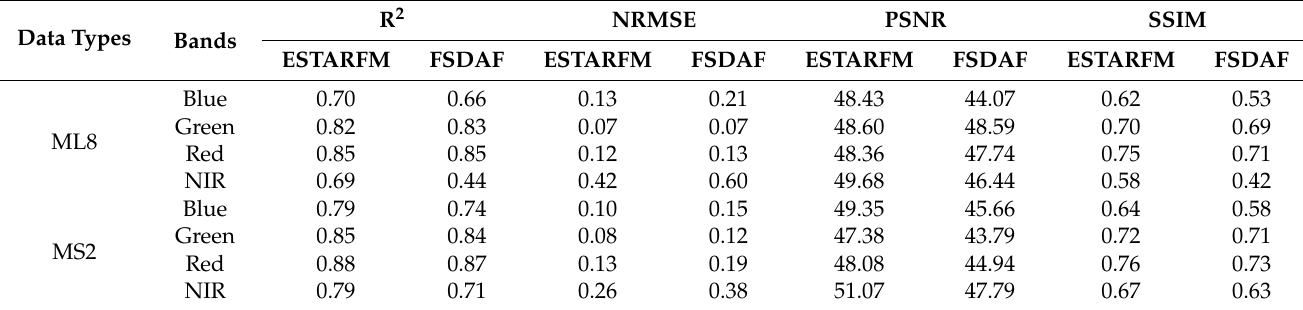
Figure 8. Scatter plot of the correlations (R 2 ) between Landsat 8 and Sentinel 2 bands. Table 3. Quantitative evaluation of image fusion